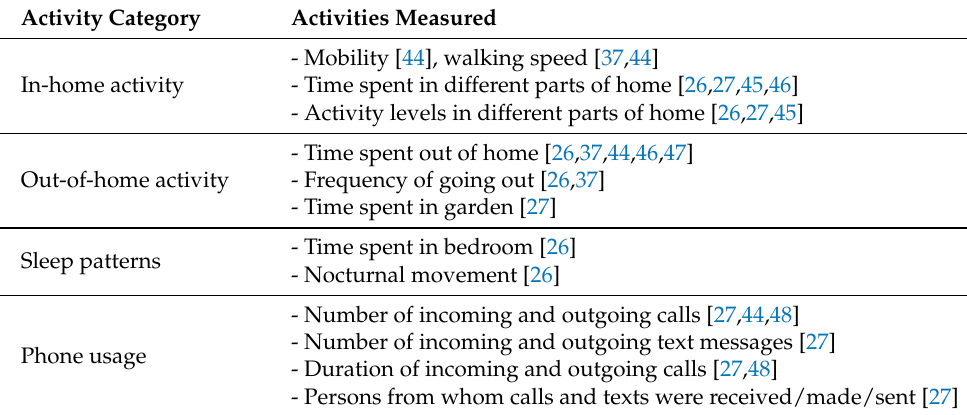
Table 2. Categories of activity patterns measured from sensor